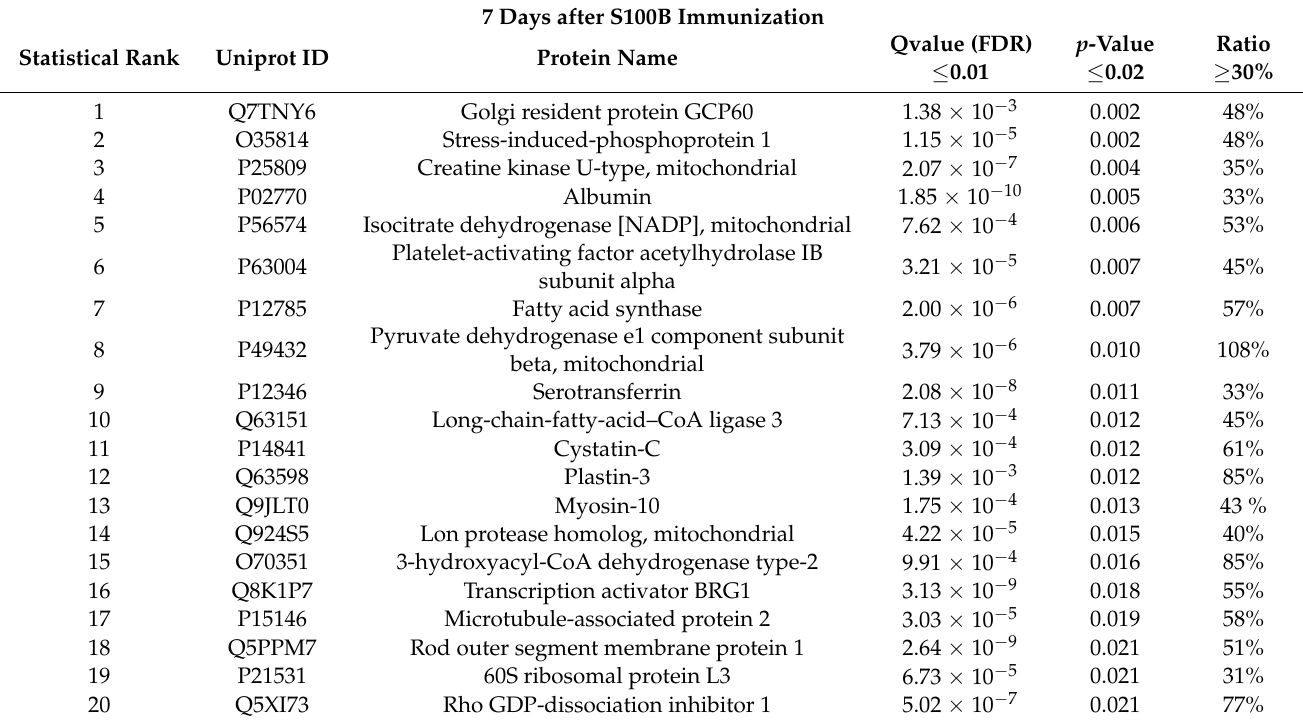
Table 1. The top 20 differential proteins 7 days after S100B immunization. Proteins quantified in ≥ 80% of the S100B and control groups are ranked based on the lowest p -value ( ≤ 0.02). 7 Days after S100B Immunization